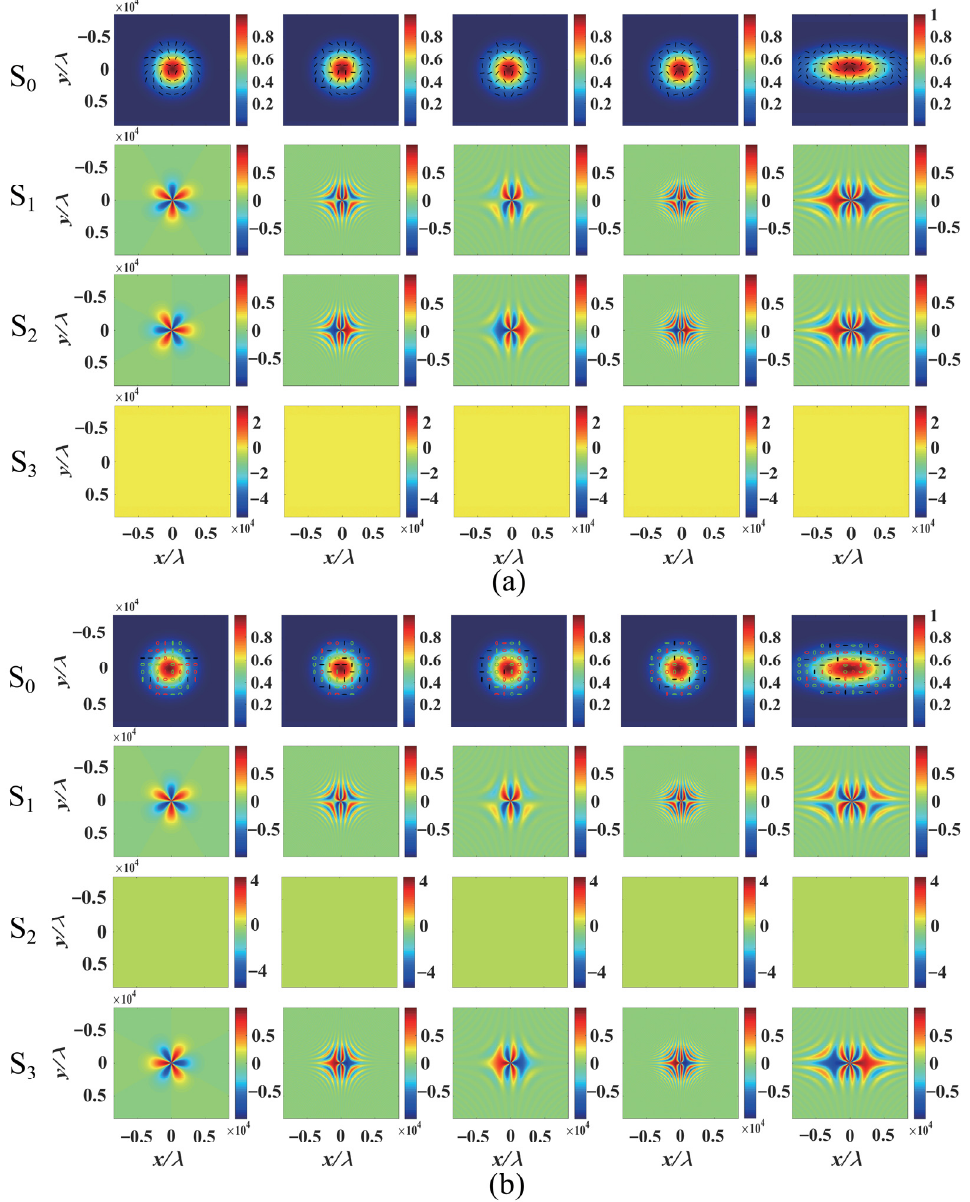
Figure 2. The Stokes parameters of the initial SoP of a twisted beam with different modulating parameters for a ( a ) locally linear polarized light field; ( b ) hybrid polarized light field. The parameters in the figure from columns 1 to 5 are, sequentially: u 1 = 0, u 2 = 0, m 1 = 4, m 2 = 1; u 1 = 10, u 2 = 0, m 1 = 4, m 2 = 1; u 1 = 10, u 2 = 7, m 1 = 4, m 2 = 1; u 1 = 10, u 2 = − 7, m 1 = 4, m 2 = 1; u 1 = 10, u 2 = 7, m 1 = 4, m 2 = − 1. The plots in columns 1–4 are isotropic beam σ x = σ y = 5 mm, and the fifth column is an anisotropic beam σ x = 2 σ y = 4 mm. In the plots in the first rows of ( a , b ), the black lines denote linear polarizations, and the ellipses in red and green represent the left- and right-circular polarizations, respectively. Here, the unit of u i is mm − 2 , and the size of any graph is 8500 λ × 8500 λ